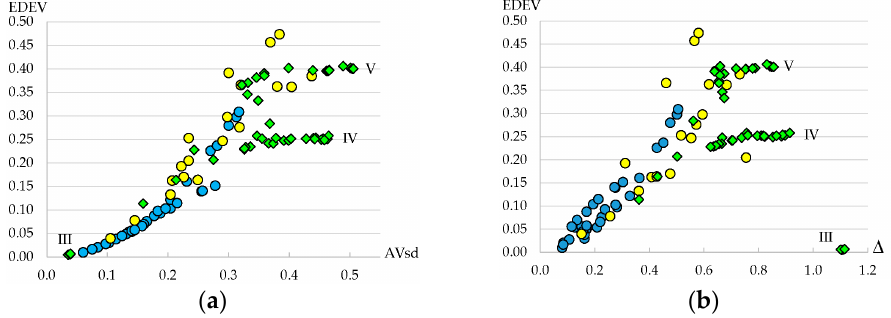
Figure 8. Correlations between EDEV X and internal distortion parameters of incomsartorite (Topa et al. [17]; structure data by courtesy of Dan Topa): ( a ) standard deviation of distances— AVsd , ( b ) displacement of the central atom from the centroid— ∆ . Blue circles represent Pb, yellow circles are mixed As–Pb positions, and green diamonds are pure As sites. Roman numerals denote coordination numbers of As.